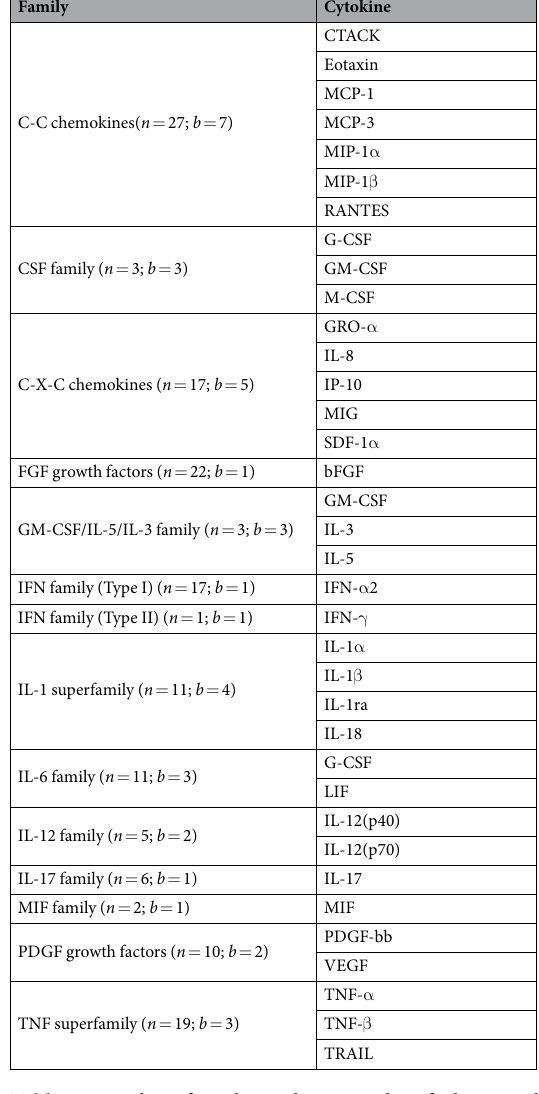
Table 4. Families of cytokines that were identified in RBC lysates ( n = the number of proteins in each family and b = the number of analytes available on the assayed Bio-Plex